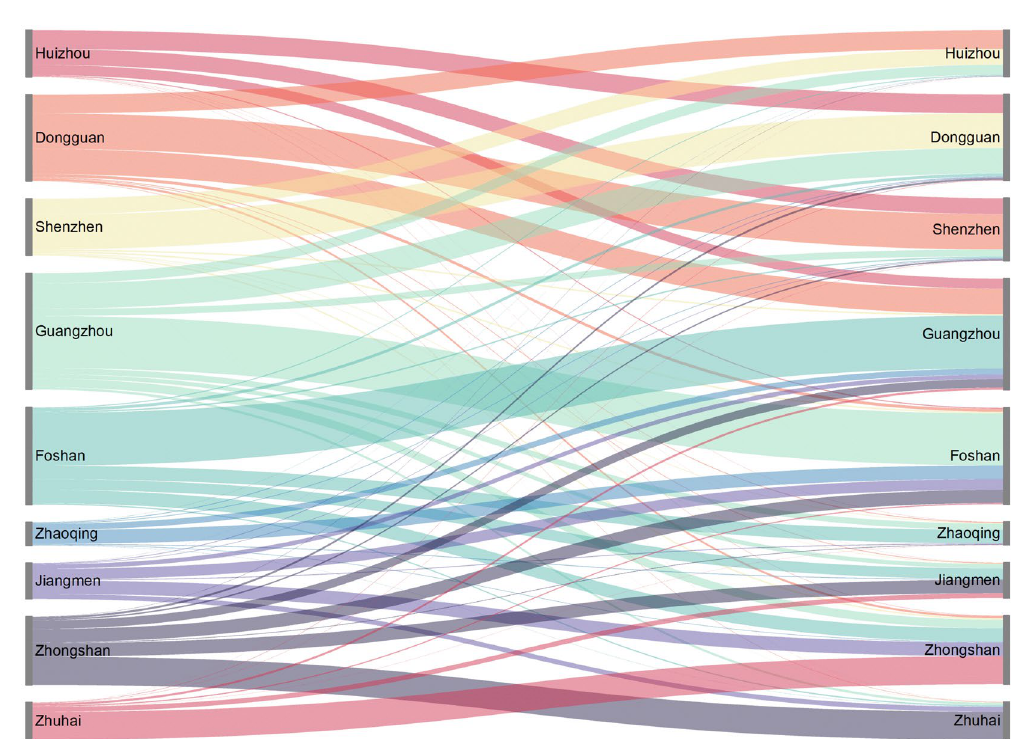
Figure 9. Recorded bilateral intercity movements for the city pairs in the